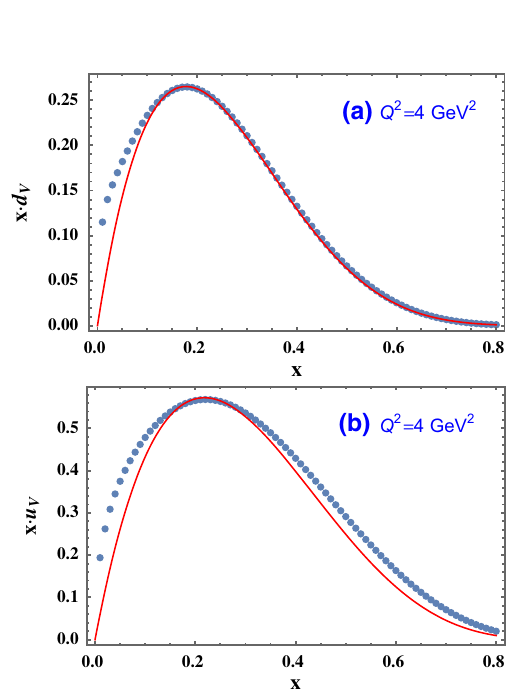
Fig. 13 Comparison of the results of the fitting of mean-field model to the xq V ( x ) distribution for d- ( a ) and u- ( b ) quarks. Data points corresponds to the CT14nnlo parameterization for central PDF sets and the shaded areas shows the uncertainties of PDFs estimated through the PDF error sets (for details see Ref. [38])